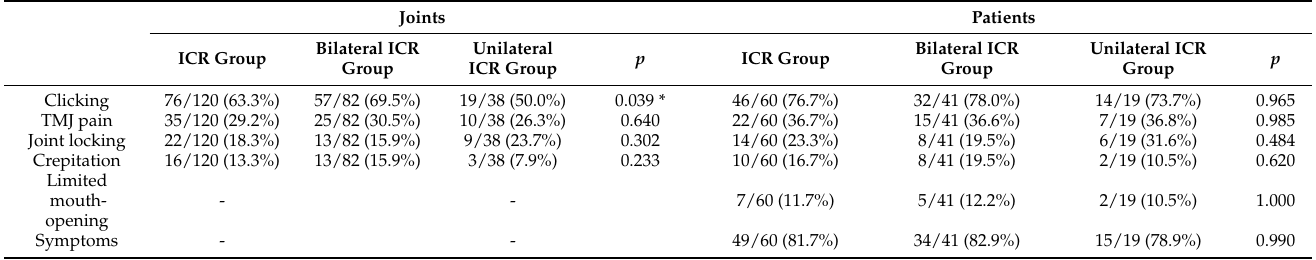
Table 2. Frequencies and percentages of self-reported symptoms in the ICR group.